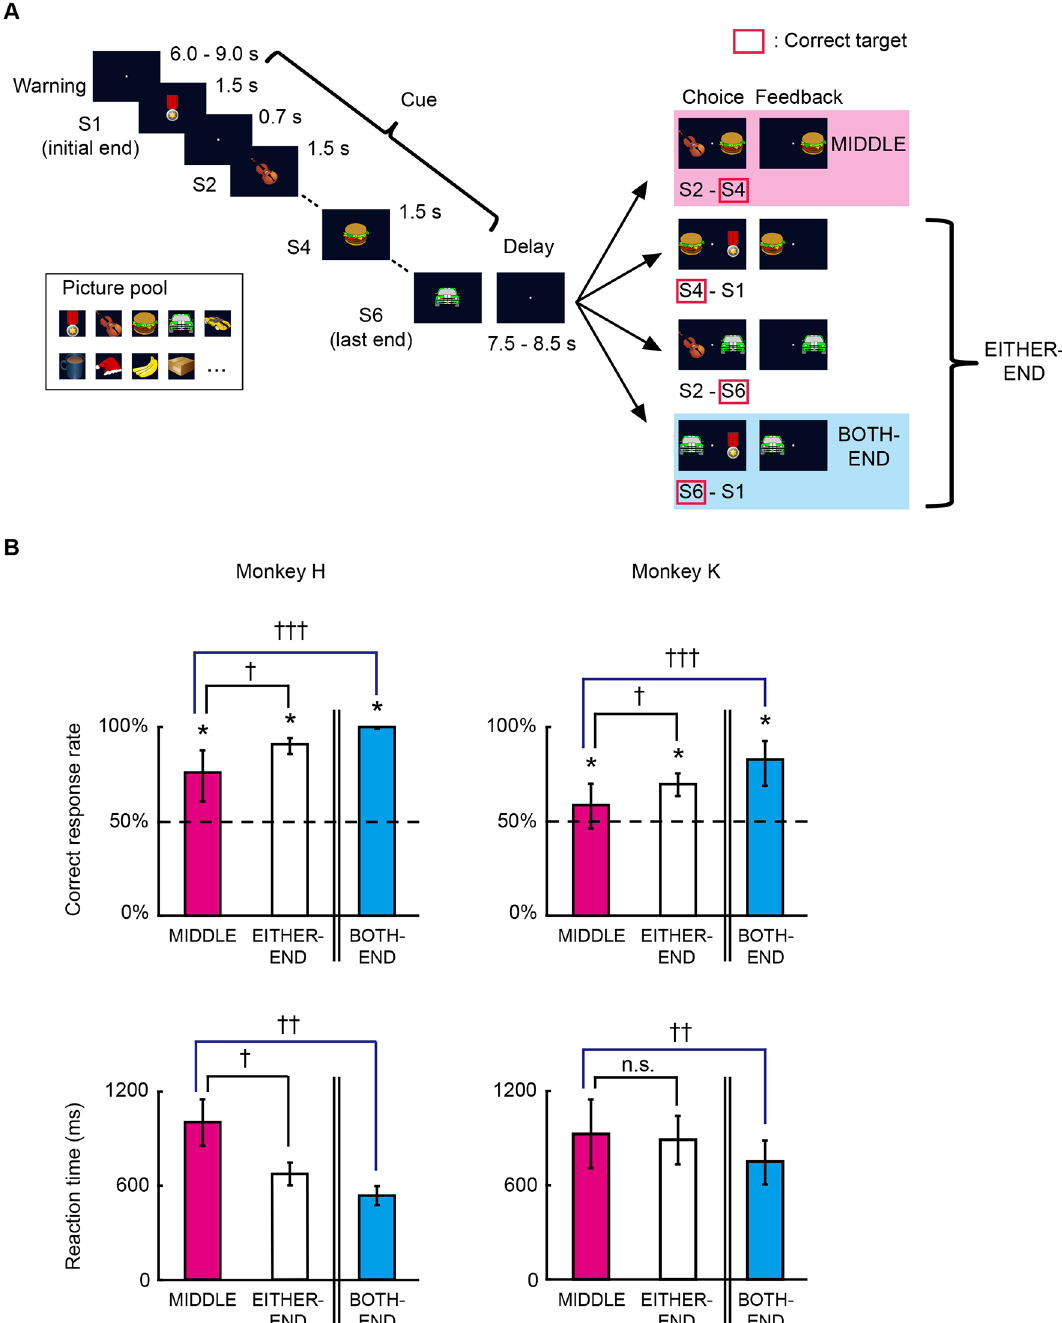
Fig 1. Temporal-order judgment task and behavioral performance of monkeys. (A) Trial structure in the temporal-order judgment task. In each trial, monkeys pulled a joystick to initiate the trial (Warning), after which a list of stimuli was presented serially (Cue). After a delay (Delay), two stimuli from the list were presented simultaneously (Choice). The monkeys were required to select the stimulus that had been presented more recently in the list. The time parameters and trial structure for monkey H are shown here. The stimuli were selected from a 1,200-picture pool of natural and artificial objects (from Microsoft Clip Art or HEMERA Photo-Object database) in a pseudorandom order. The images provided in this figure are representations only and were not used in the experiment. (B) Percentages of correct responses (upper) and reaction times (lower) for each monkey during scanning sessions. The dashed line indicates the chance level. Error bars indicate standard deviation (SD) across sessions. * p < 10 − 4 , t -test. † p < 10 − 4 , †† p < 10 − 5 , ††† p < 10 − 7 , paired t